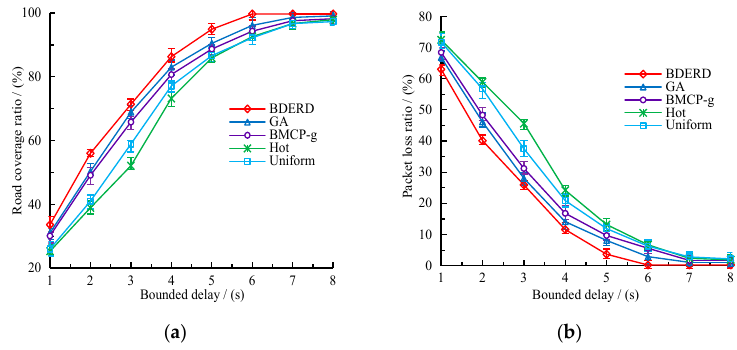
Figure 4. ( a ) Road coverage ratio versus bounded delay; ( b ) packet loss ratio versus bounded delay.